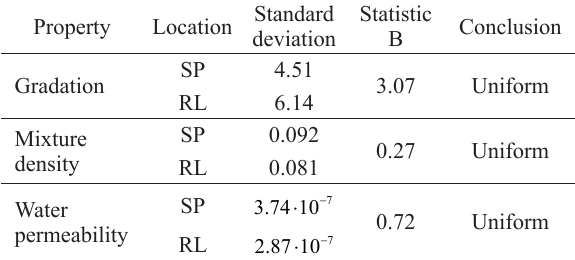
Table 5. The results of checking uniformity of variances in KG1 mixture samples taken from different locations based